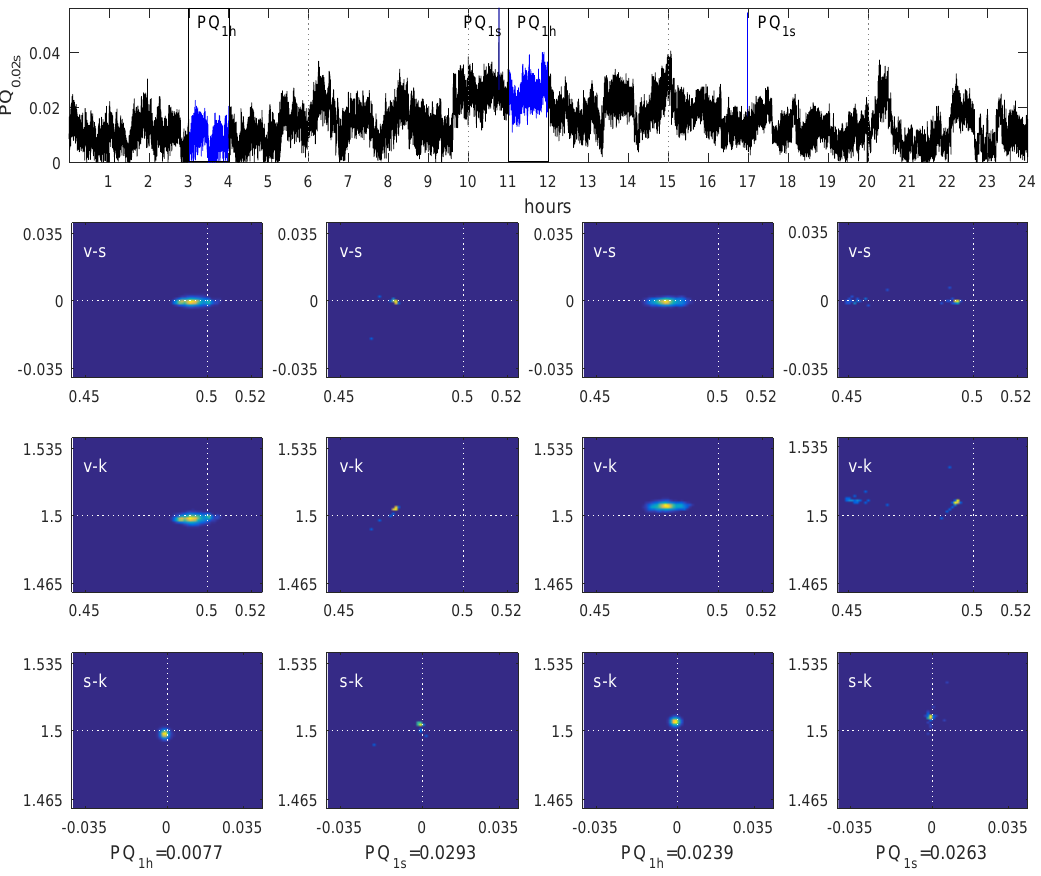
Figure 4. PQ 0.02 s values during 24 hours, from which different intervals can be analyzed.